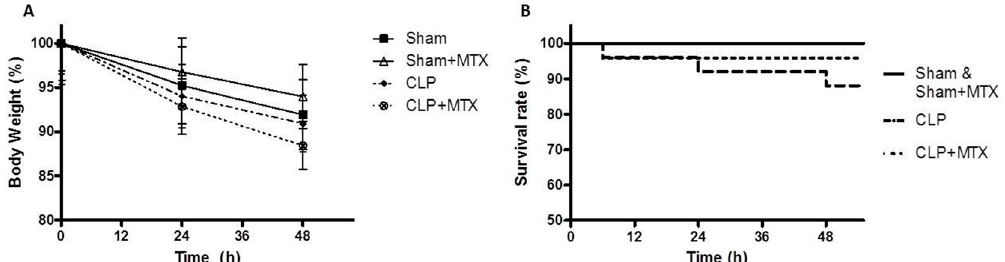
Figure 1. Body Weight and Survival. ( A ) Body weight measured at 0 h, 24 h and 48 h in all groups. ( B ) Representation of the survival rate in all groups in the curse of the experiment. Values represent group mean ± SEM. Sham and Sham + MTX n = 15, CLP and CLP + MTX n = 22.